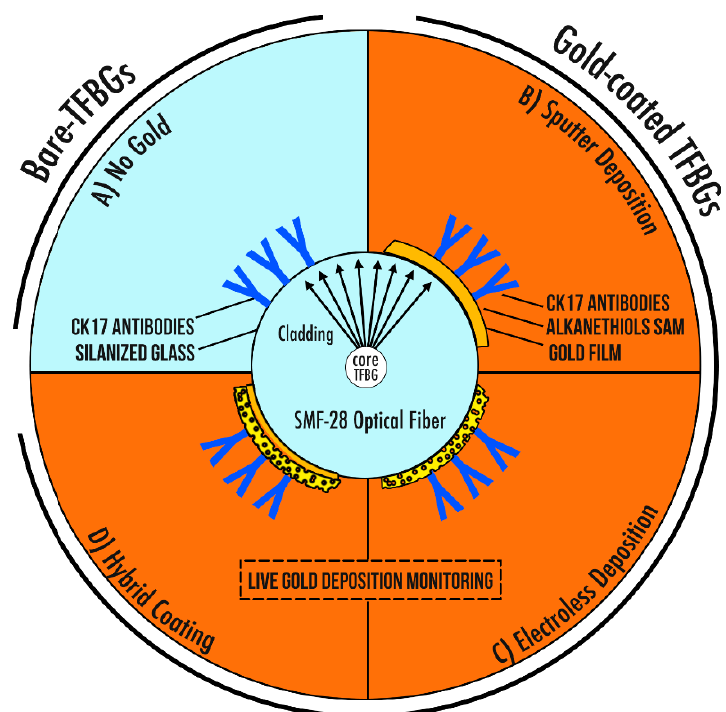
Figure 2. Scheme of the four studied sensing configurations. ( A ) The bare-TFBGs with adsorbed antibodies on the silica surface. ( B ) The sputter deposition under vacuum and the covalent bonding of anti-CK17 antibodies on the gold film. ( C ) The electroless deposition of gold and the covalent bonding of anti-CK17 antibodies on the agglomerated Au particles. ( D ) A hybrid-coating coupling a deposition of 4 nm Au by sputter-coater followed by an ELP deposition, which is functionalized using covalent bonding of anti-CK17 antibodies.